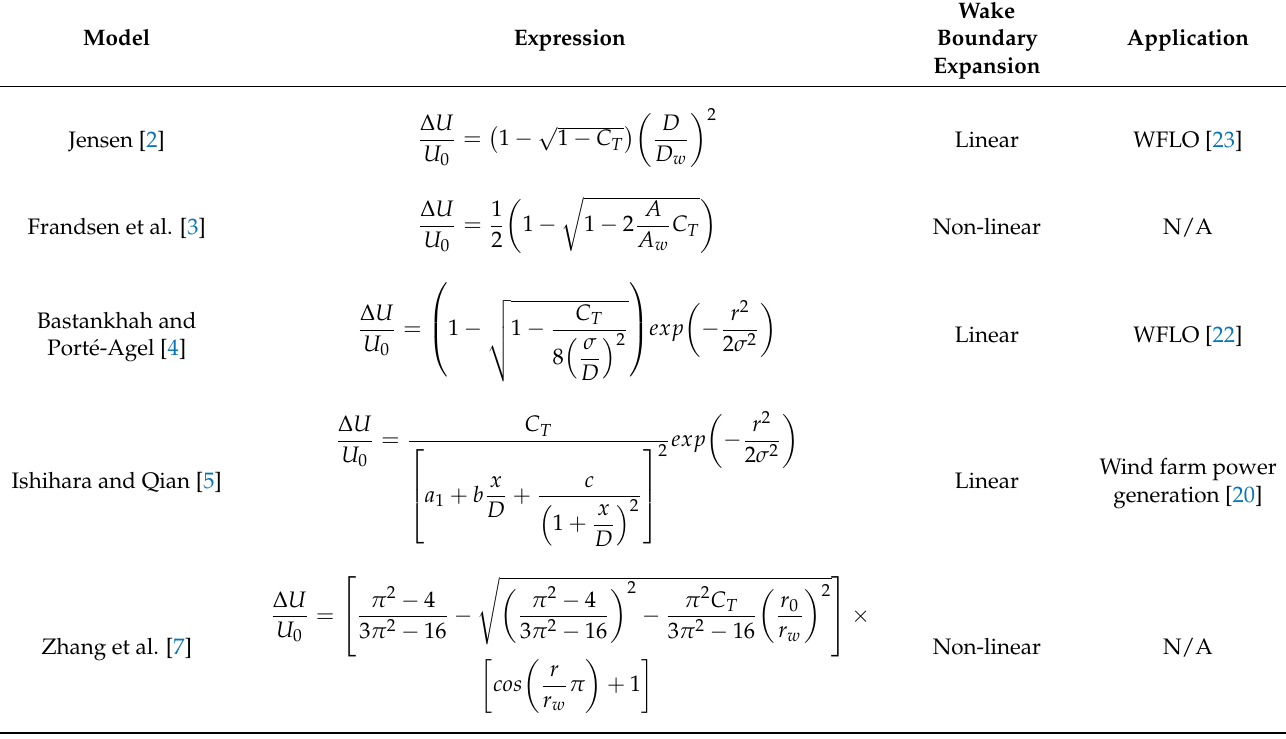
Table 1. Analytical and empirical wake models in the far wake